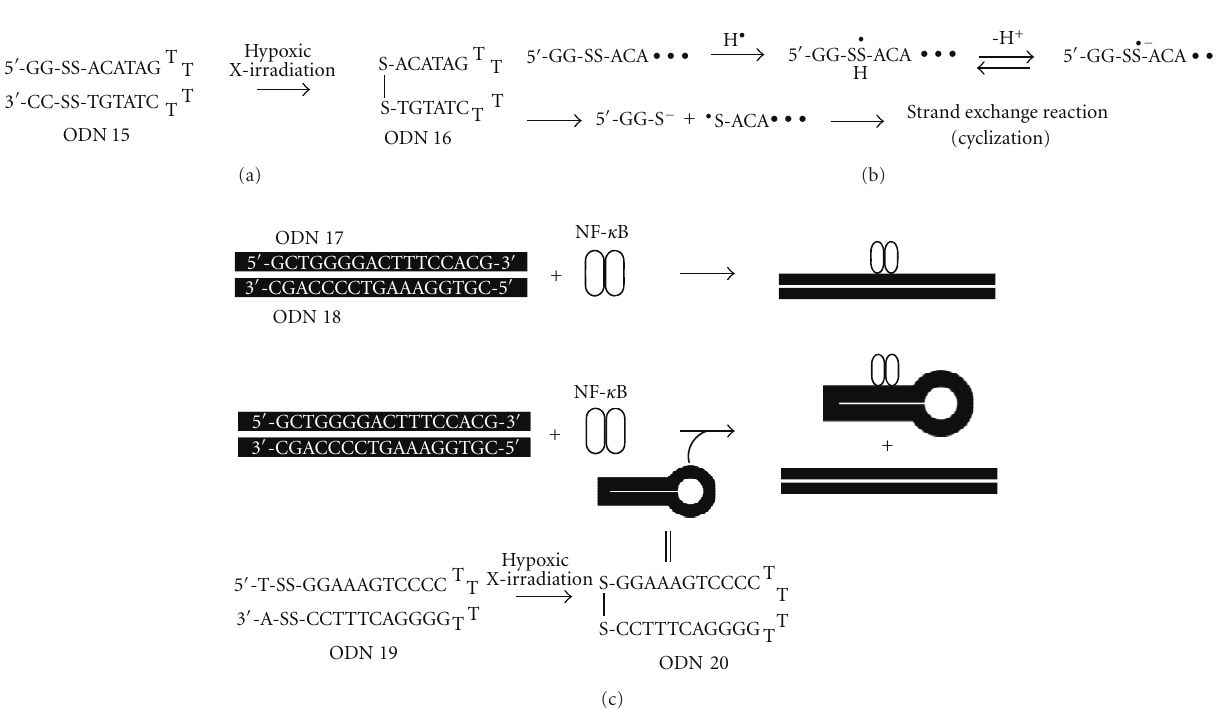
Figure 7: (a) Radiolytic cyclization of hairpin-type oligodeoxynucleotides possessing disulfide bonds. (b) The possible reaction mechanism for the cyclization of ODN 15 upon X-ray irradiation. (c) Cyclized oligodeoxynucleotides used for the transcriptional decoy